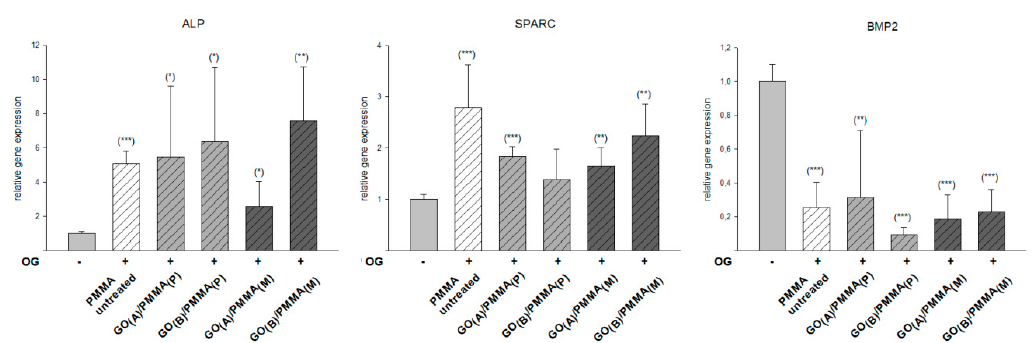
Figure 4. The expression of specific osteogenic markers (ALP, SPARC, and BMP-2) of hMSPCs cultured in the presence of osteogenic di ff erentiation medium for 21 days on the surface of GO / PMMA composites as well as untreated PMMA, compared with undi ff erentiated hMSPCs cultivated in expansion medium as the negative control; p < 0.001 ***; p < 0.01 **; p < 0.05 *.